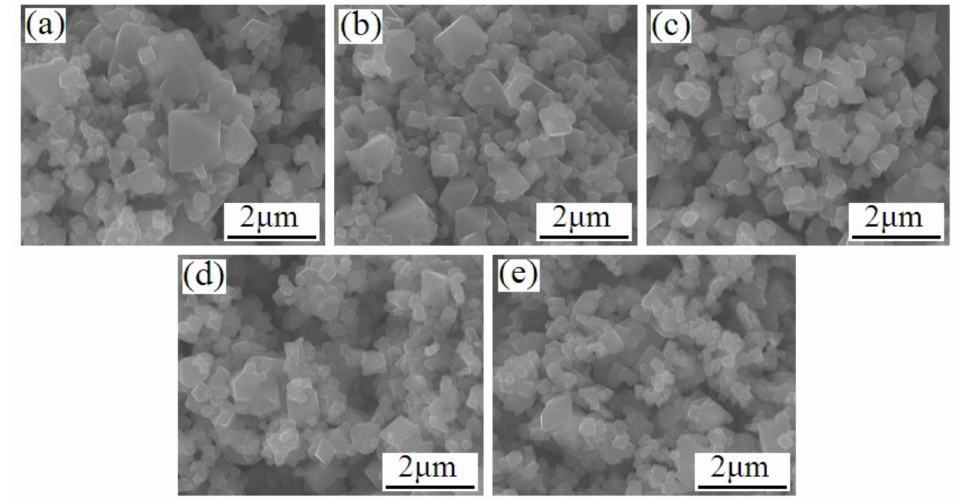
Figure 2. SEM images of the LiSi x Mn 2 − x O 4 samples: ( a ) x = 0, ( b ) x = 0.025, ( c ) x = 0.05, ( d ) x = 0.075, ( e ) x = 0.10.